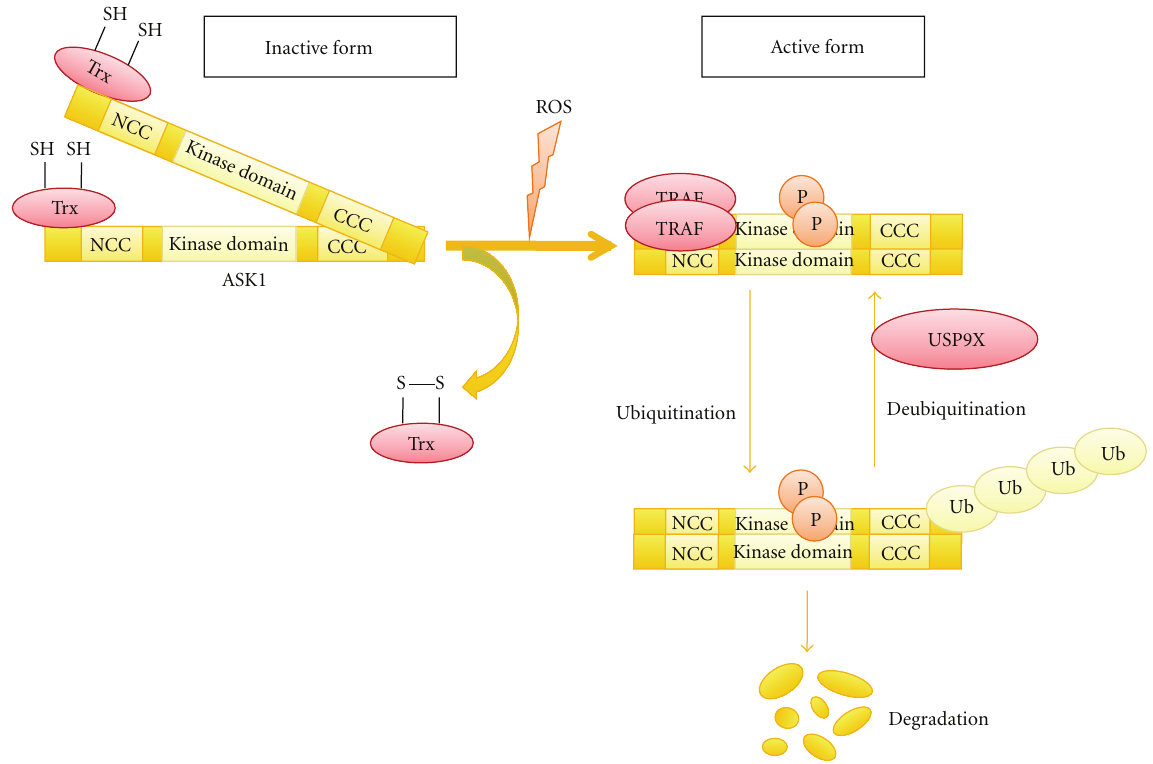
Figure 1: Mechanisms of ROS-induced ASK1 activation. Thioredoxin (Trx), a negative regulator of ASK1, is dissociated from the N-terminal region of ASK1 in response to ROS. Subsequently, TRAF2 and TRAF6 are recruited, thereby fully activating ASK1. The ROS-induced activation of ASK1 results in its ubiquitination and proteasome-dependent degradation. USP9X negatively regulates ASK1 degradation by deubiquitination, leading to the sustained activation of ASK1. CCC: C-terminal coiled-coil domain; NCC: N-terminal coiled-coil domain.